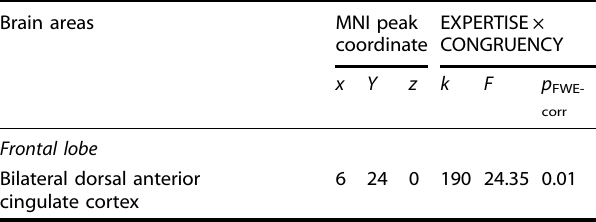
Table 2. Signi fi cant activation cluster for the interaction effect between EXPERTISE and CONGRUENCY.